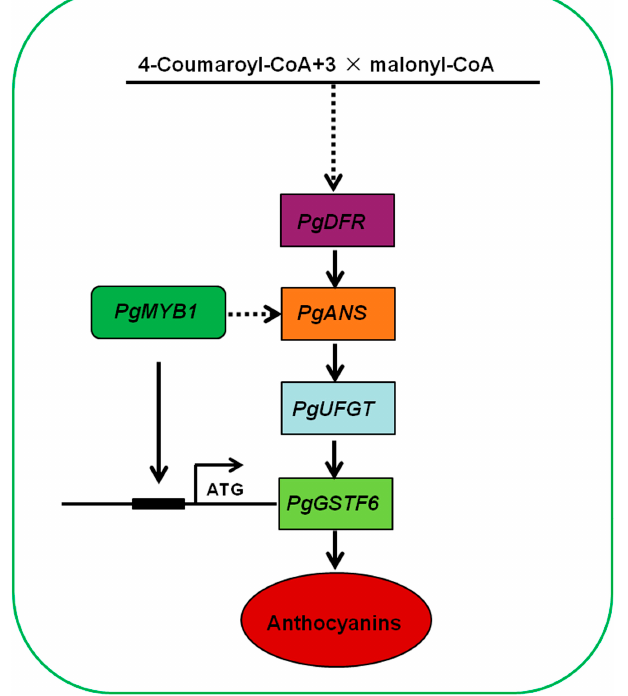
Figure 6. A working model of PgMYB1 function in anthocyanin accumulation. PgMYB1 directly binds to the promoter of PgGSTF6 , thereby activating its transcriptional expression. Additionally, knockdown of PgMYB1 downregulated the expression of PgANS , indicating that PgMYB1 may acti- vate transcriptional expression of PgANS and thus affect anthocyanin accumulation in pome- granate.